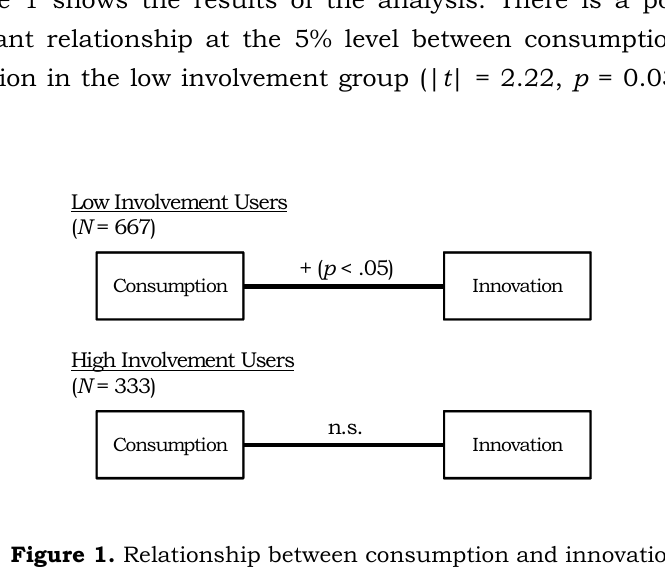
Figure 1. Relationship between consumption and innovation Note: n.s. = not